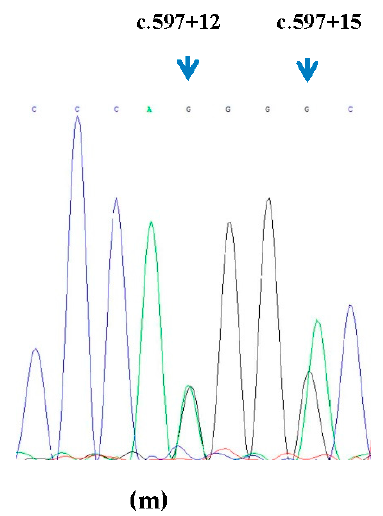
Figure 1. Sequencing maps of SNPs. ( a ) The sequencing map of SNPs (c.153C / T and c.154G / A). ( b ) The sequencing map of SNP (c.156C / T). ( c ) The sequencing map of SNP (c.180C / G). ( d ) The sequencing map of SNP (c.184 + 66C / T). ( e ) The sequencing map of SNP (c.184 + 81C / T). ( f ) The sequencing map of SNP (c.189C / T). ( g ) The sequencing map of SNP (c.281T / C). ( h ) The sequencing map of SNP (c.281T / A). ( i ) The sequencing map of SNPs (c.281C / A and c.282A / G). ( j ) The sequencing map of SNP(c.377A / G). ( k ) The sequencing map of SNP (c.378 + 5C / T). ( l ) The sequencing map of SNP (c.459A / G). ( m ) The sequencing map of SNPs (c.597 + 12A / G and c.597 + 15A / G). Table 3. Variation and amino acid change in amplified regions. Gene Variable